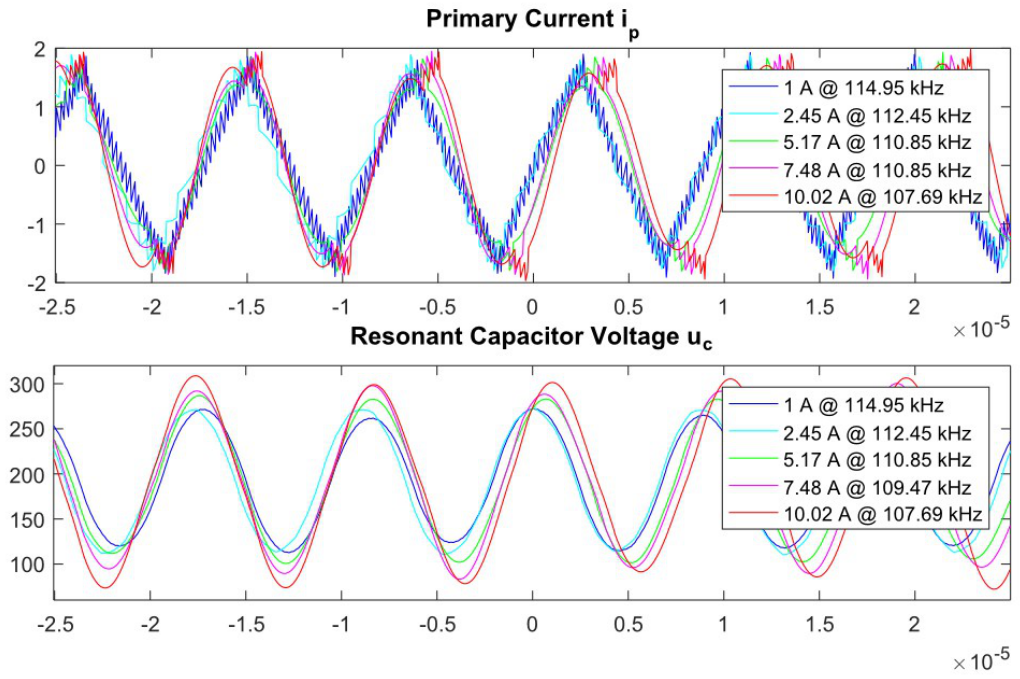
Figure 3. Waveforms of conducted simulations with the mathematical model.